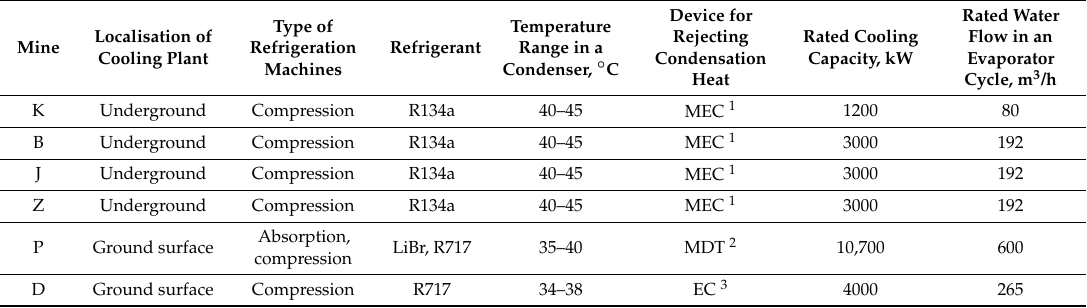
Table 1. Rated cooling capacity of tested refrigeration plants in coal